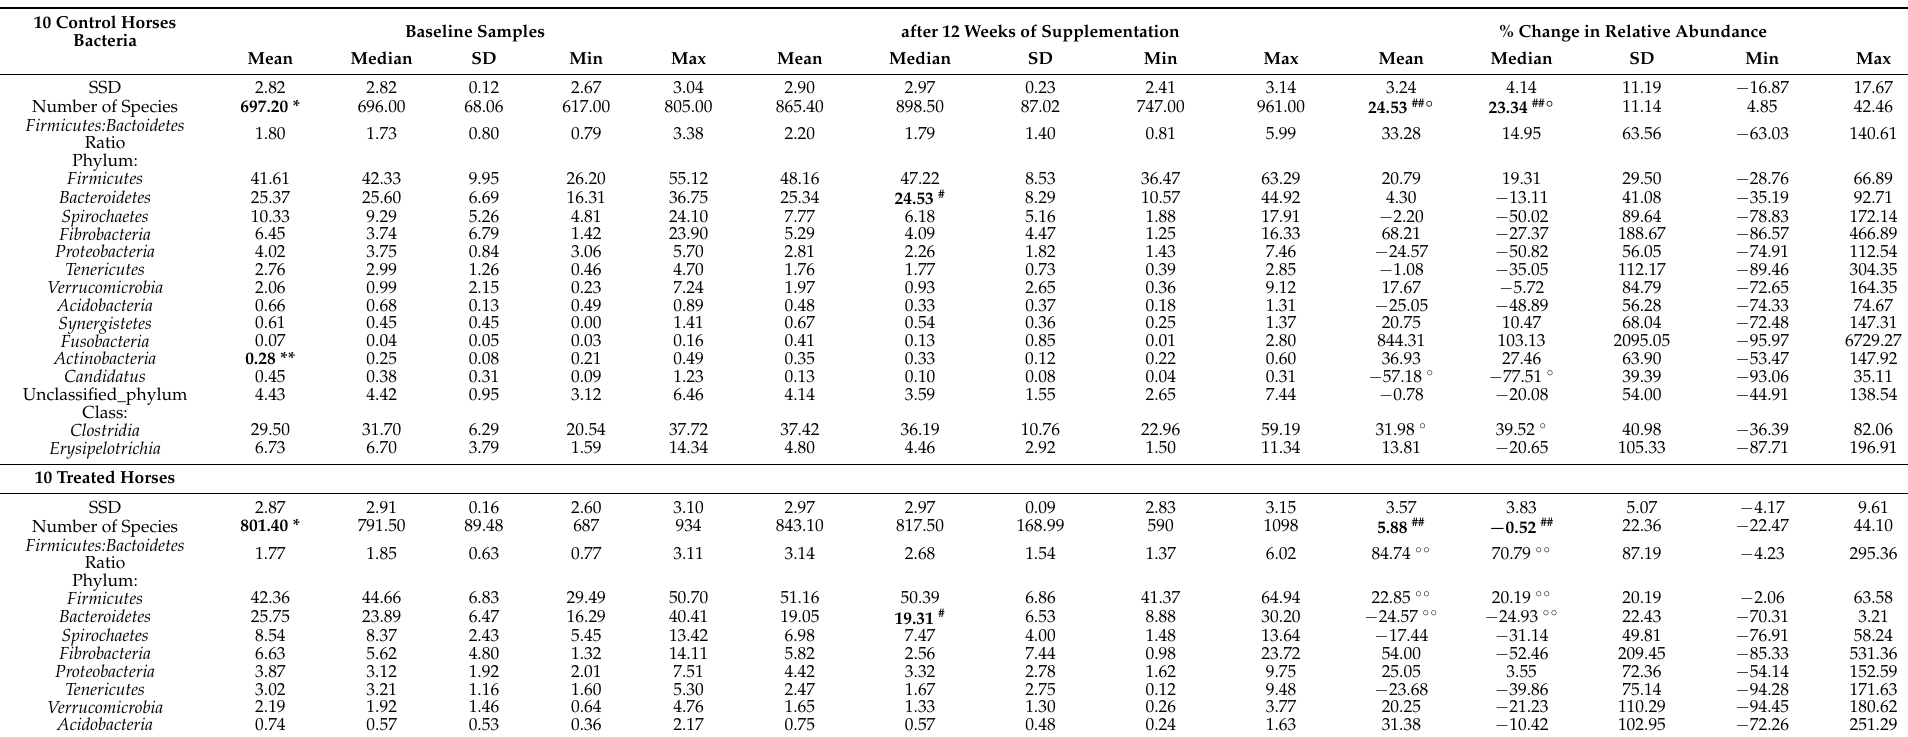
Table 2. Descriptive statistics showing the mean, median, standard deviation (SD), minimum (Min) and maximum (Max) values for the relative abundances of bacteria as a proportion of the total bacterial counts at baseline and 12 weeks with the percent change from baseline for 10 control horses and 10 treated horses. Significant differences between control and treated horses (within columns) are highlighted in bold. Significant differences for percent change from baseline to the 12-week sample being significantly different from zero are highlighted with symbols and in